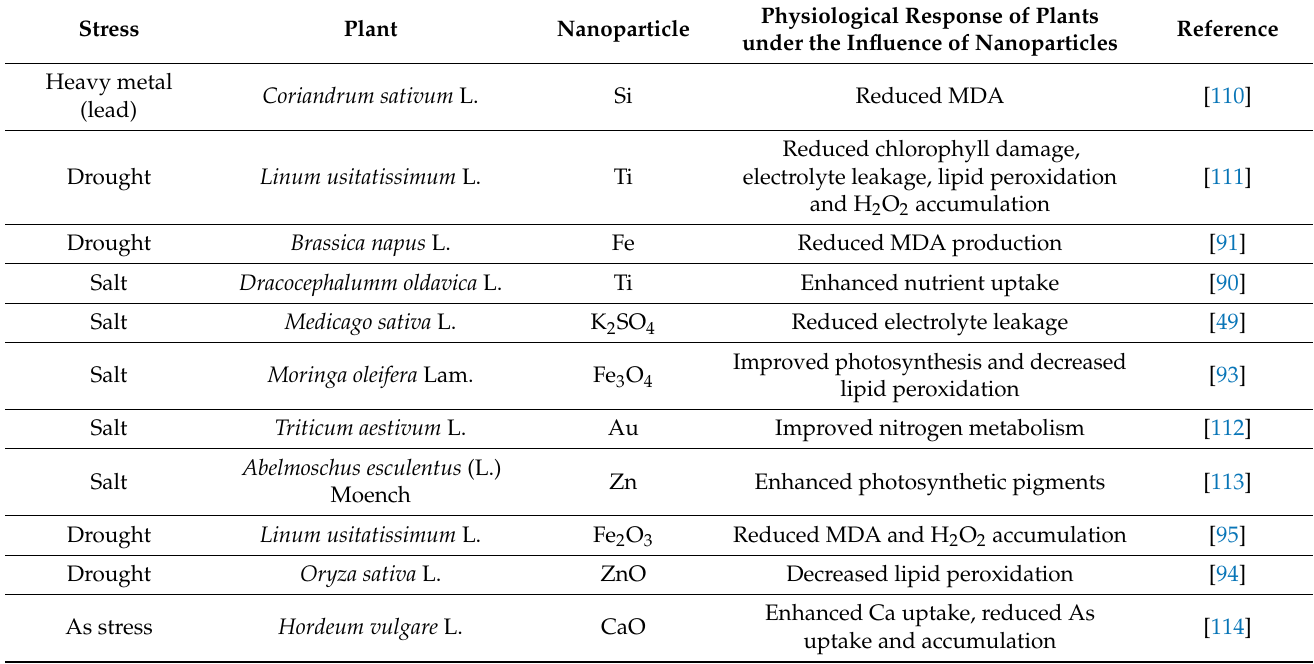
Table 2. Physiological changes under the influence of